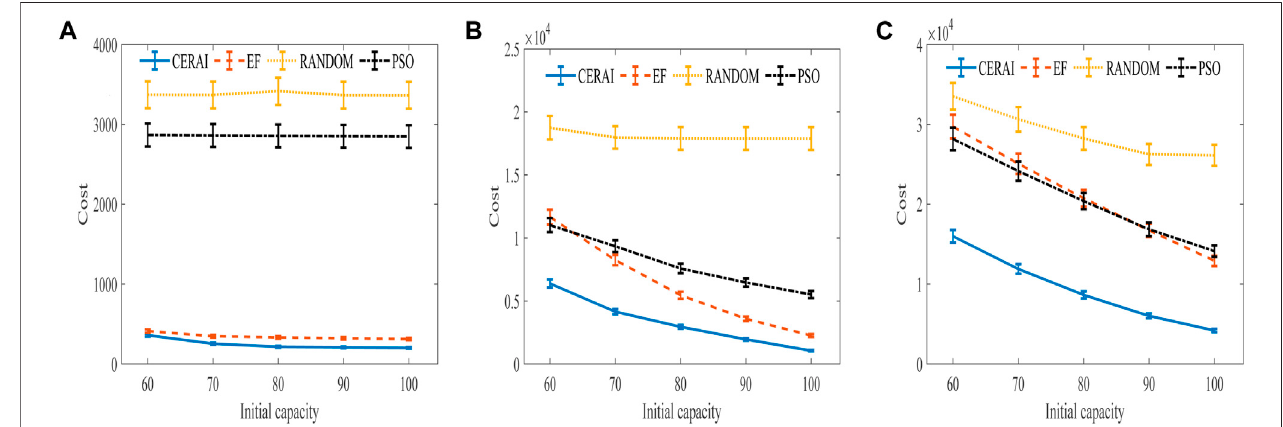
FIGURE 7 | Experimental results of the impact of computing time duration on cost with private cloud. (A) Experimental results of low intensity group. (B) Experimental results of medium intensity group. (C) Experimental results of high intensity group.